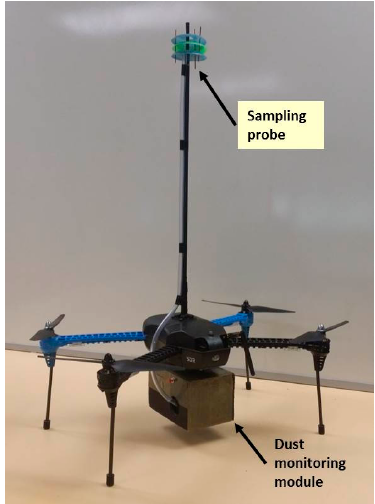
Figure 2. Physical configuration of the multi-rotor UAV with the sampling probe and dust monitoring module attached.